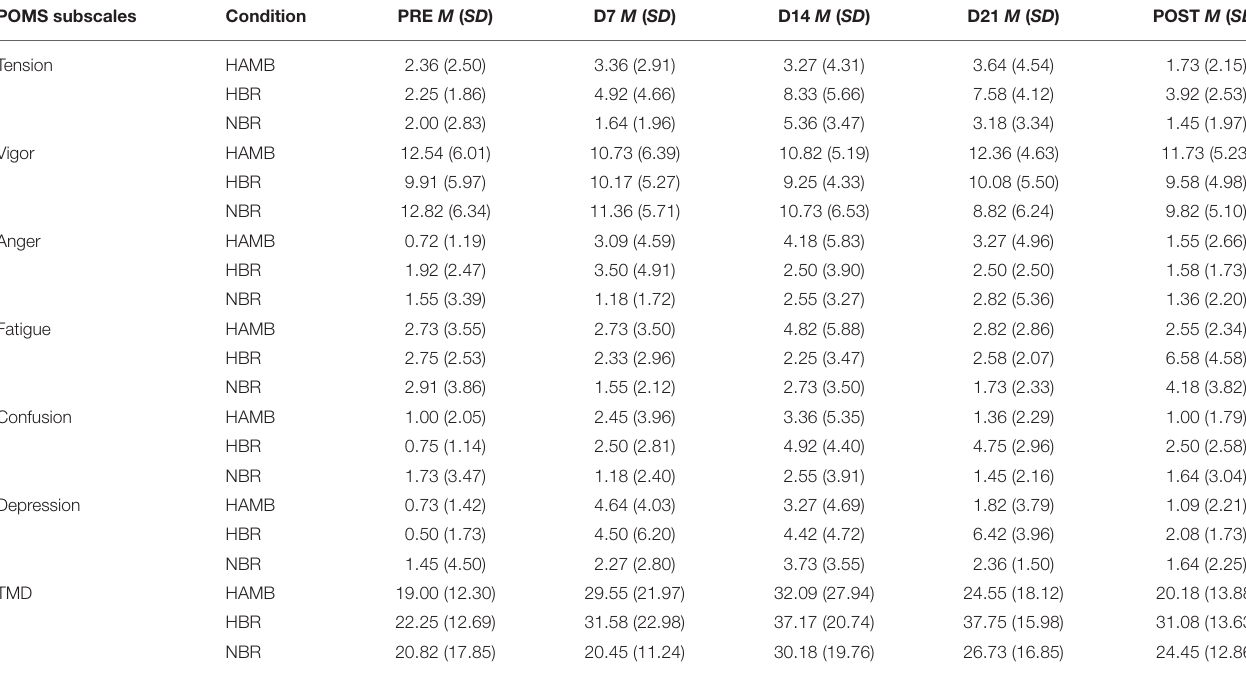
TABLE 2 | Descriptive Statistics of the Profile of Mood State (POMS) subscale values before during and after experimental conditions. POMS